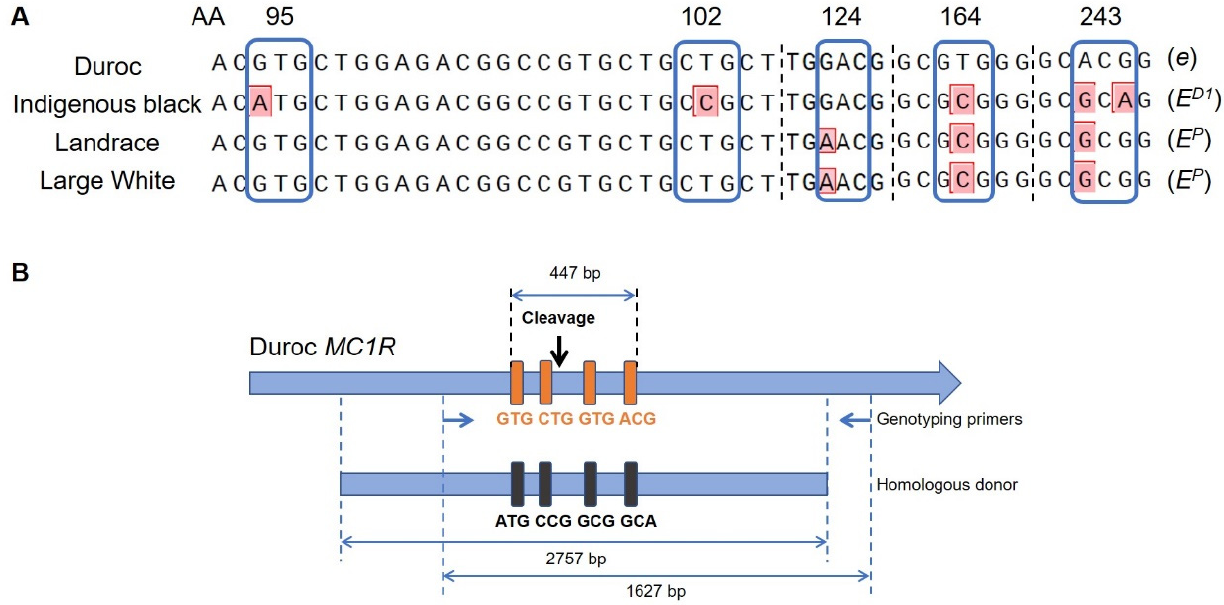
Figure 1. Gene editing strategy at the MC1R locus for coat color switch in Duroc pigs. ( A ) MC1R sequence alignment among different pig breeds. The four SNPs at AA positions 95, 102, 164, and 243 of the MC1R gene distinct between Duroc breed ( e ) and Chinese indigenous black breed ( E D1 ) are shown in red. Landrace and Large White breeds have a specific D124N substitution compared with other breeds, which is the key variation forming the E P allele. The E allele associated with each MC1R variant is indicated in parentheses. ( B ) CRISPR system and donor design for SNP substitutions in Duroc MC1R . A guide RNA (gRNA) was designed to recognize the cleavage target in the SNP regions. A 2757-bp DNA sequence was amplified from the MC1R genomic region in Chinese indigenous black pigs as the donor to replace the Duroc MC1R homologous region by HR. The gRNA-recognized sequence in the donor was synonymously mutated to avoid second CRISPR cleavage after HR. The genotyping primers amplifying a 1627-bp sequence covering homology arm and adjacent genome region after HR were used in PCR assay to detect the occurrence of gene replacement. AA, amino acid